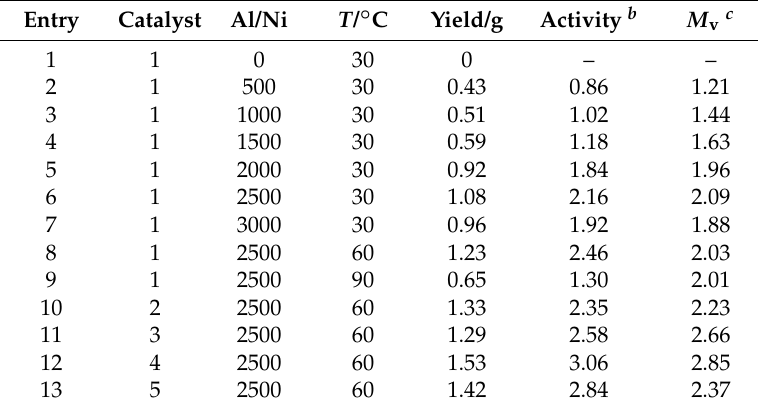
Table 2. Polymerization of norbornene Complexes 1 – 5 activated by MAO a .